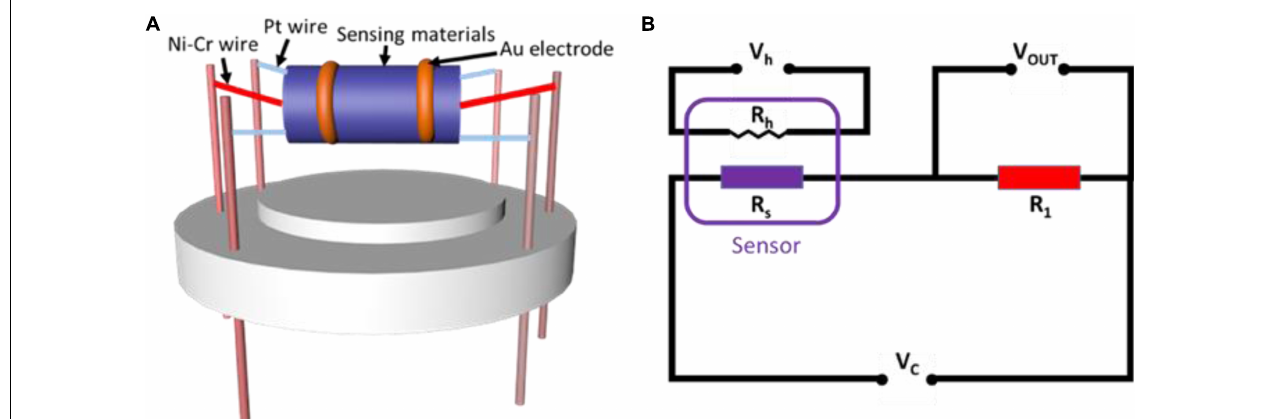
FIGURE 1 | (A) Schematic structure of the gas sensor. (B) The measuring electric circuit of the sensor.